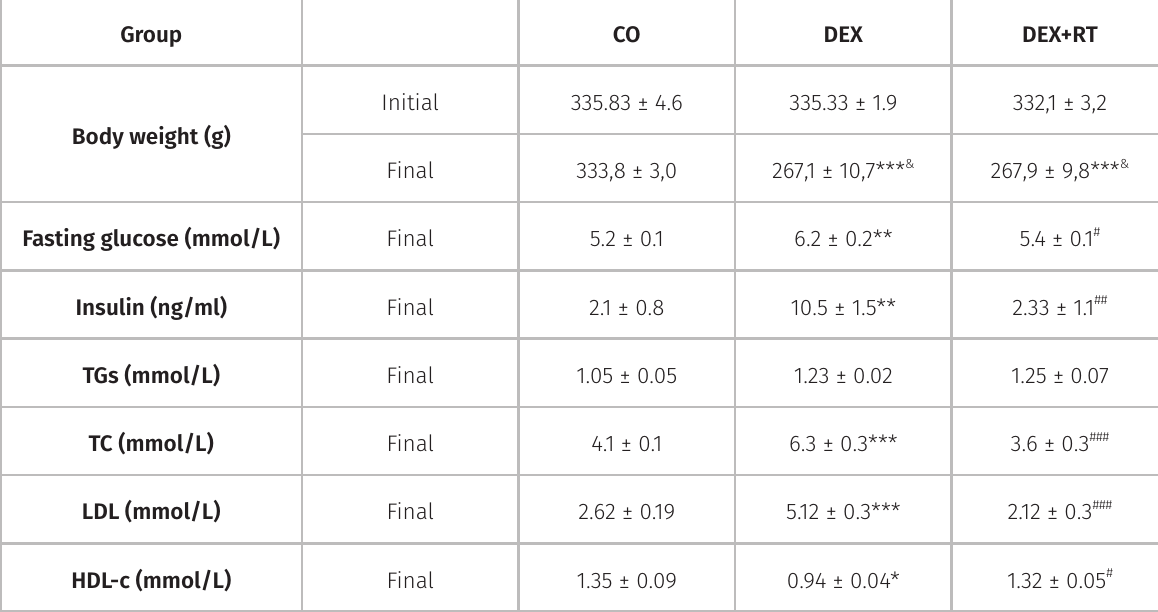
Table I. Bodyweight in the first and eighth week, fasting glucose, insulin, TG, TC, LDL and